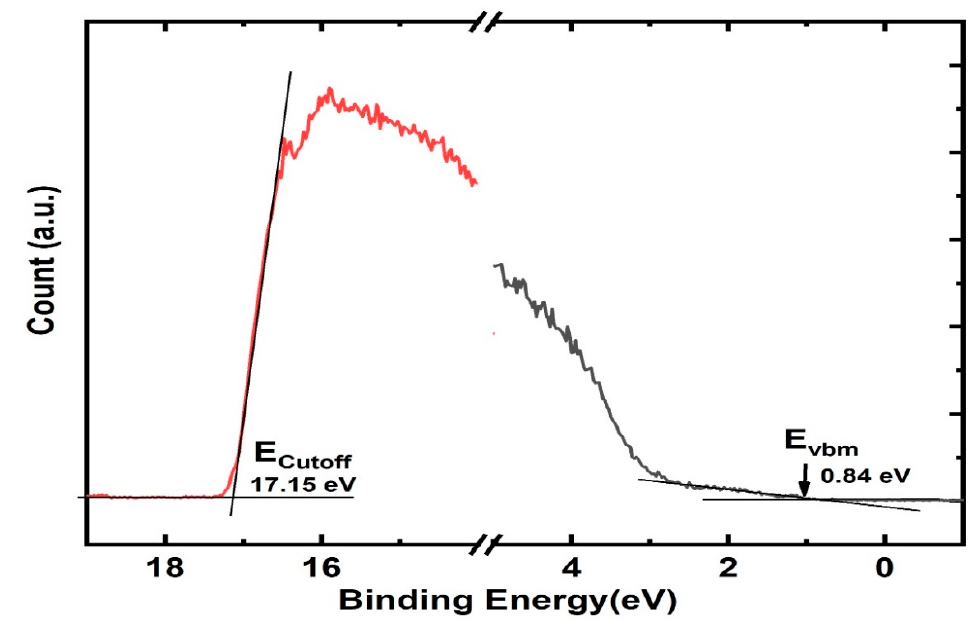
Figure 4. UV/Vis photoemission spectra (He(I)) of α -sexithiophene/indium tin oxide for direct determination of work function and VBM.